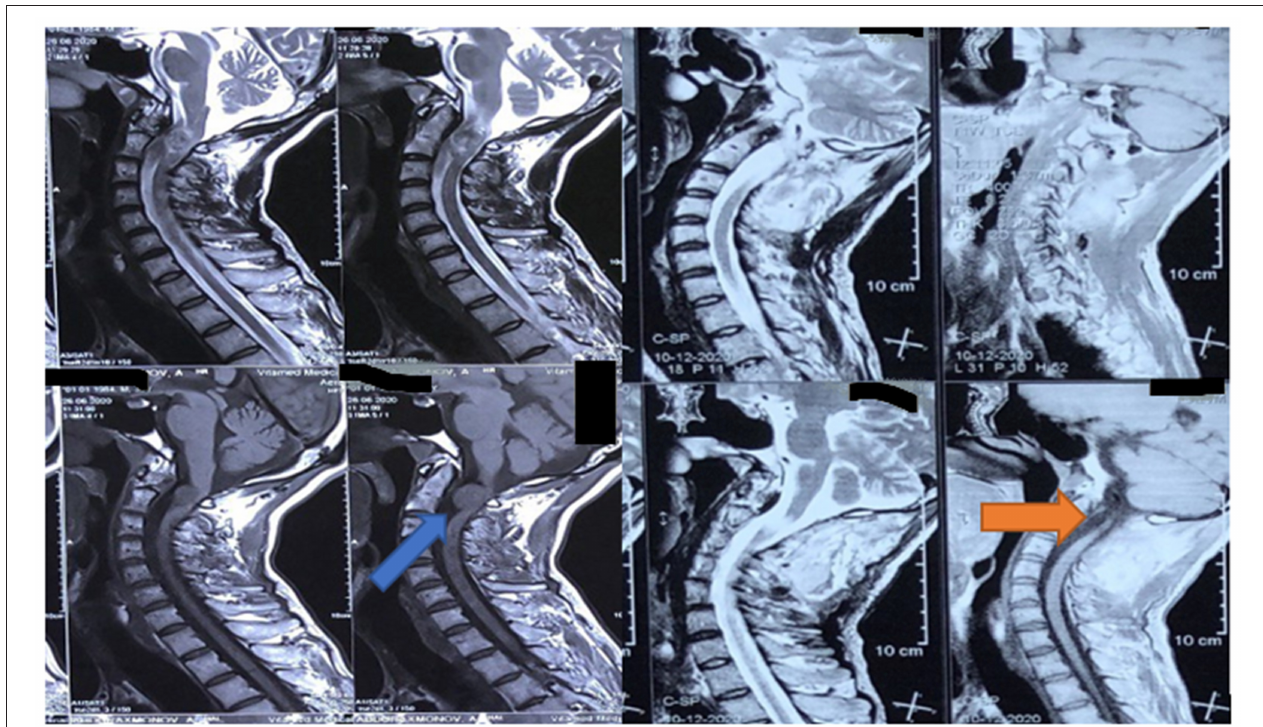
FIGURE 3 | A pre-and post-surgery MRI of 32 years old with ependymoma of the roots of the cauda equina and syringomyelia between L3-L5 (blue arrow).